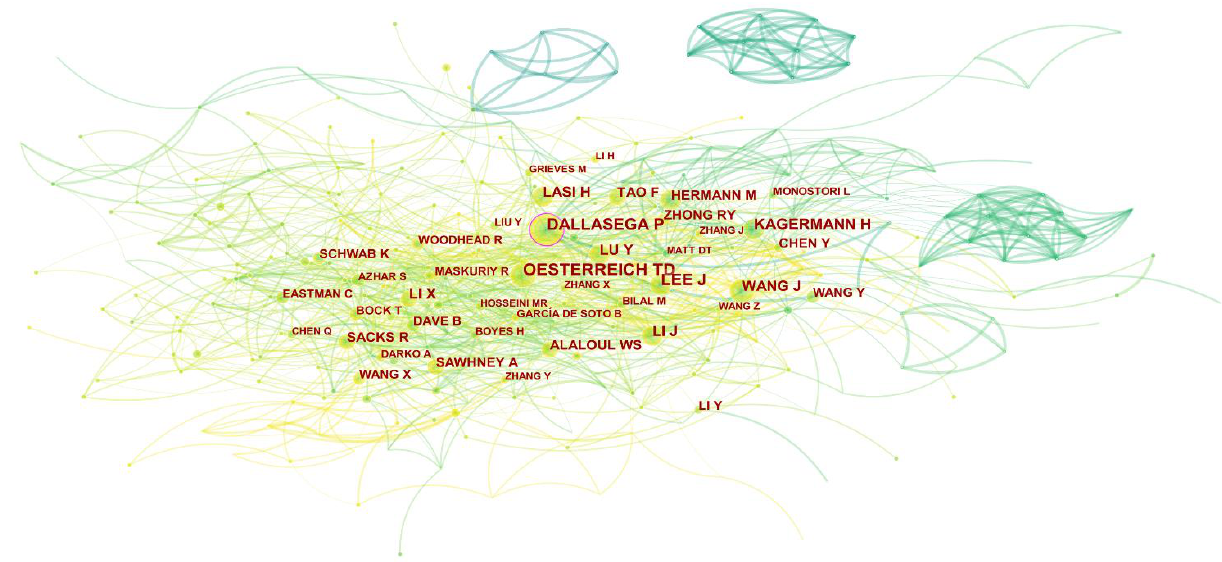
Figure 16. Author co-citation network for publications related to Industry 4.0 in construction. The final network map is the document co-citation network displayed in Figure